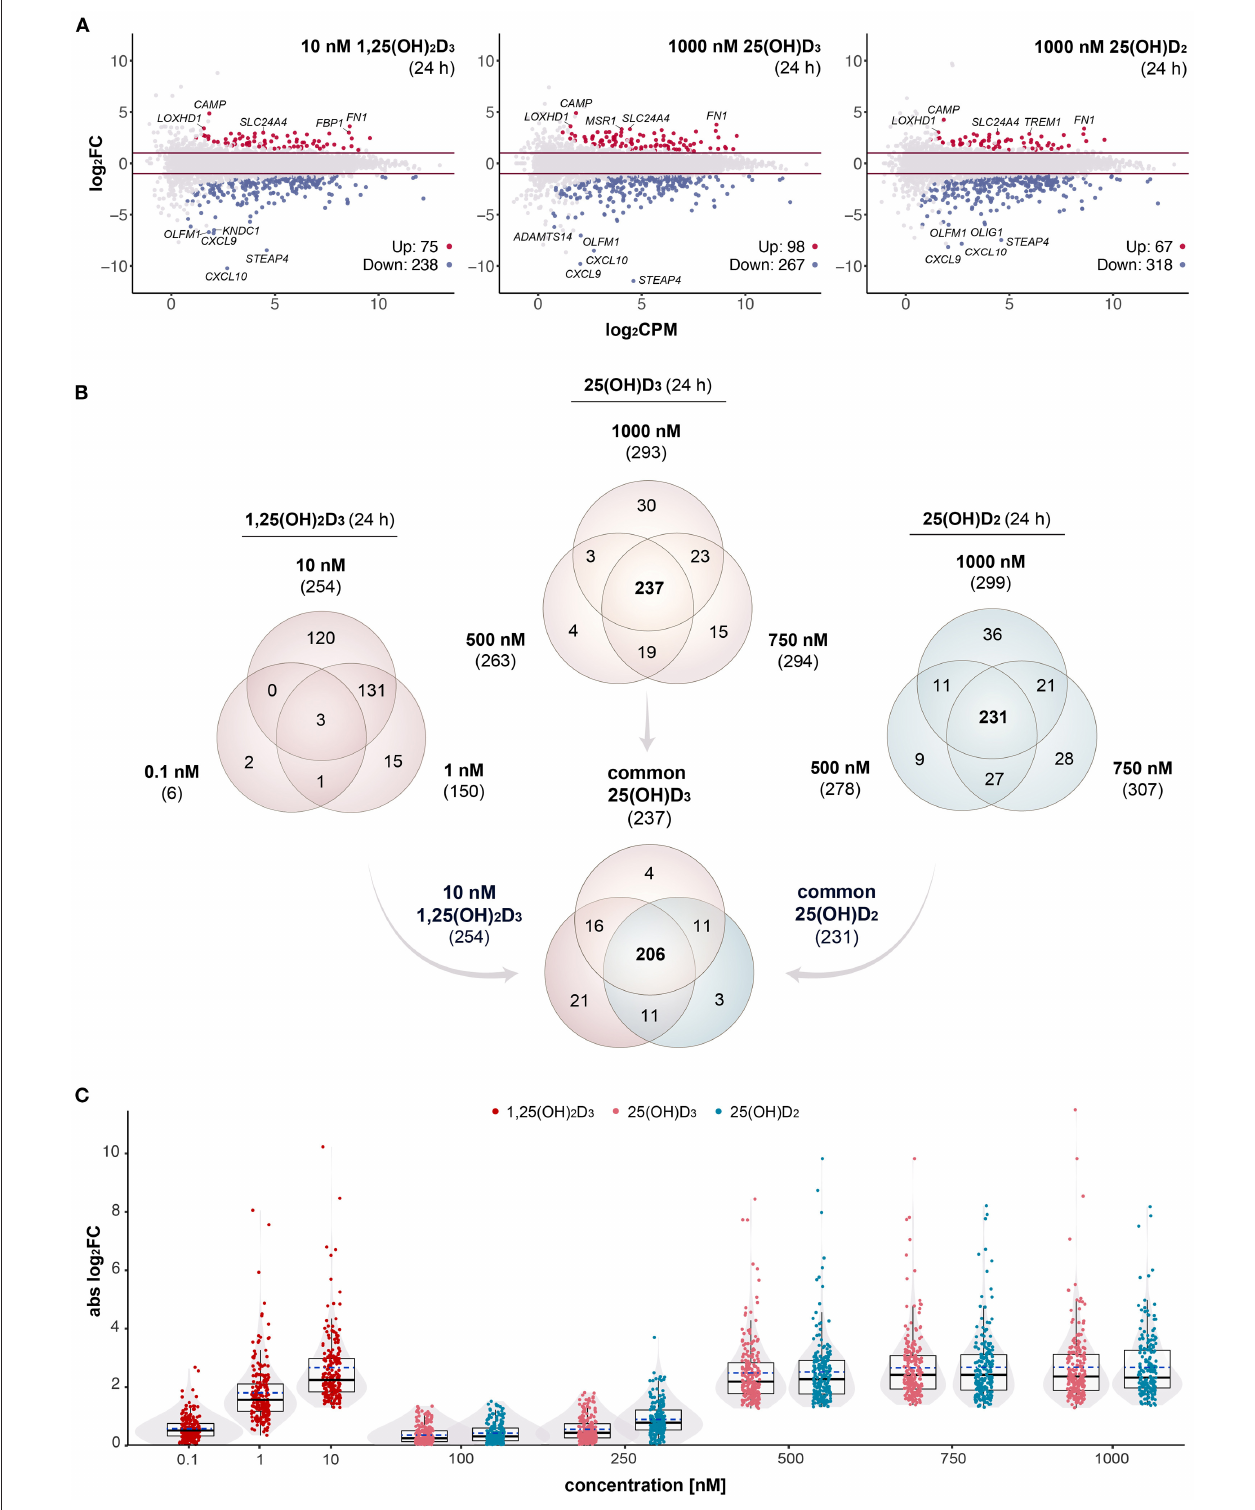
FIGURE 1 | Gene-regulatory potential of vitamin D metabolites. MA plots display the genome-wide transcriptional response of PBMCs treated for 24 h with 10 nM 1,25(OH) 2 D 3 , 1000 nM 25(OH)D 3 or 1000 nM 25(OH)D 2 in comparison to solvent (0.1% EtOH) (A) . For each gene, the change of expression (log 2 FC) between